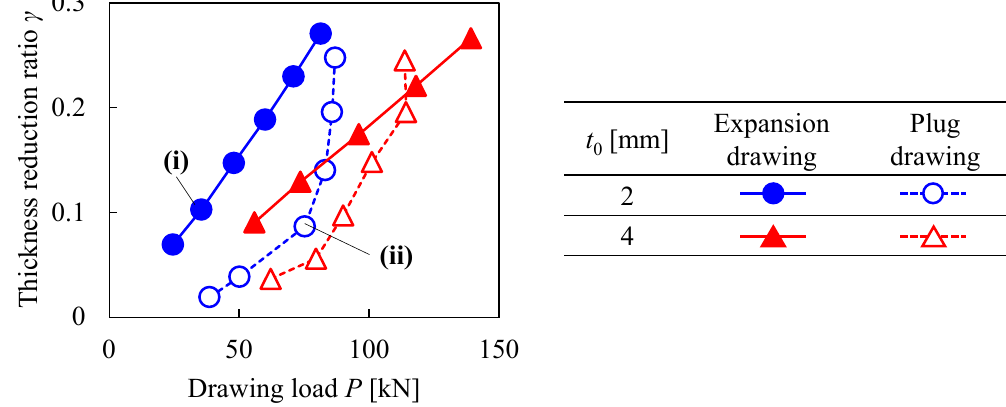
Figure 11. Relationship between thickness reduction ratio γ and drawing load P (STKM13C, 2D FEM).